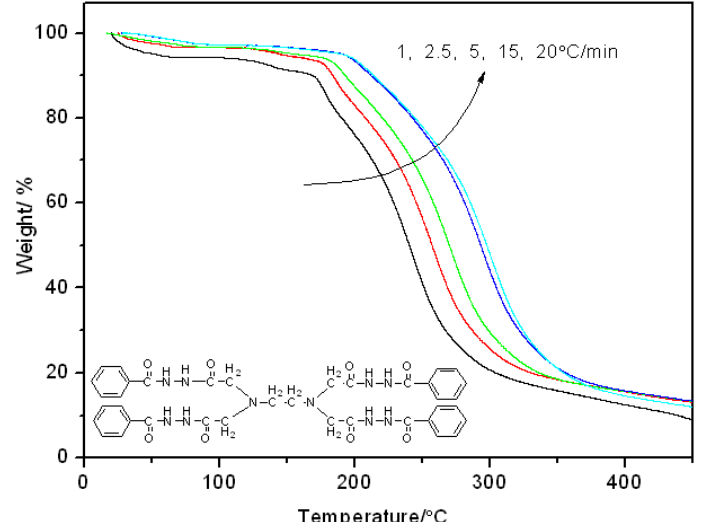
Figure 2. TGA curves of N, N, N, N' -Tetra(benzoyl) ethylene diamine tetraacetic acid dihydrazide. Nucleating effect of